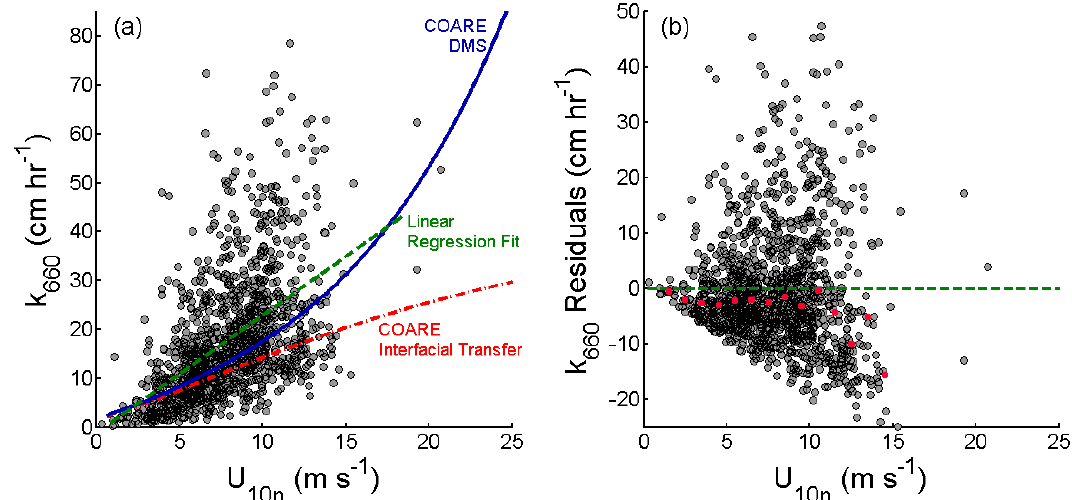
Figure 3. (a) 10min average DMS gas transfer coefficients vs. mean horizontal wind speed during the SOAP cruise, expressed as k 660 and U 10 n (see Methods). For reference, the NOAA COARE model output for DMS is plotted, calculated using average SOAP input parameters and the turbulent/molecular coefficient, A = 1 . 6, and the bubble-mediated coefficient, B = 1 . 8. The red dashed line is interfacial transfer velocity only. The blue solid line includes the bubble contribution to gas transfer. The green dashed line is the least squares linear regression fit to the SOAP 10min averaged data ( k 660 = 2 . 31 U 10 n − 1 . 51). (b) Residual values from the least squares linear regression fit in (a) . The green dashed line is exact agreement with linear regression model. Red squares are the median residual within each 1ms − 1 wind speed bin. Negative deviation of the median residuals from the linear regression demonstrates the positive skew in k 660